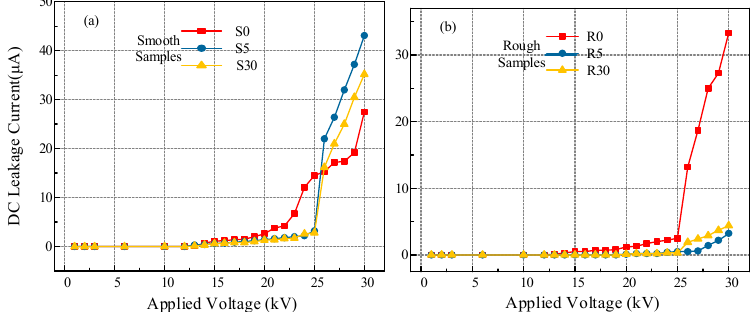
Figure 11. DC leakage current curves of samples under di ff erent solution soaking. ( a ) Smooth samples soak in 0.1% sodium chloride solution; ( b ) Rough samples soak in 0.1% sodium chloride solution water.